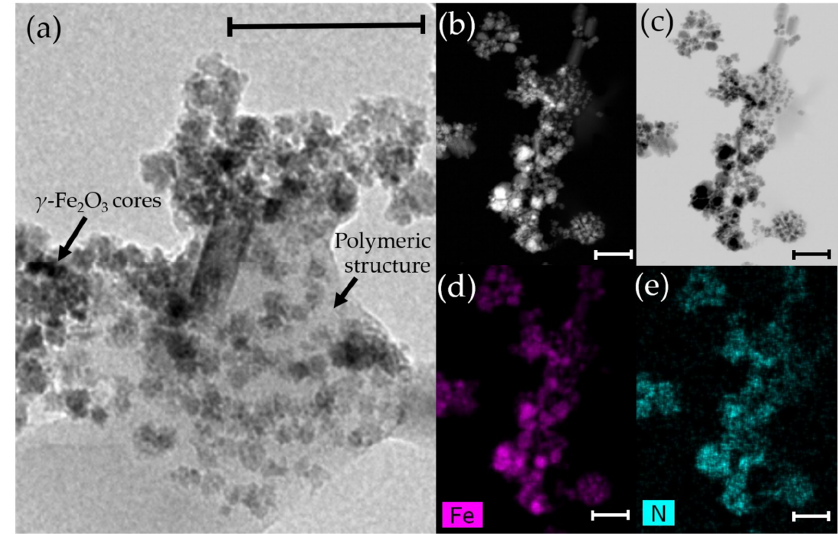
Figure 2. ( a ) HRTEM, ( b ) HAADF-STEM, and ( c ) ABF-STEM images of the ( γ -Fe 2 O 3 /PLGA)/CS nanocomposites; EDX mapping analysis of the ( d ) Fe and ( e ) N elements of the sample in ( b , c ). Bar lengths: 100 nm. The arrows in ( a ) mark the γ -Fe 2 O 3 cores inside the polymeric structure.